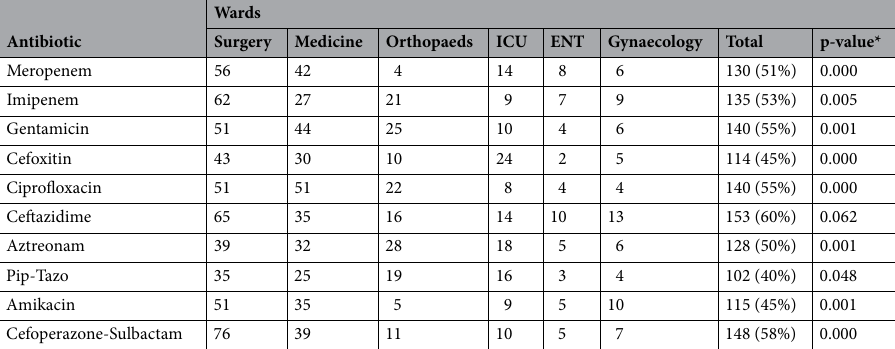
Table 3. Pattern of antimicrobial resistance in Pseudomonas aeruginosa in association with departments. Vertical ranking enlists antibiotics. Horizontal ranking enlists the department of sample collection. *p value ≤ 0.05 was considered statistically significant.